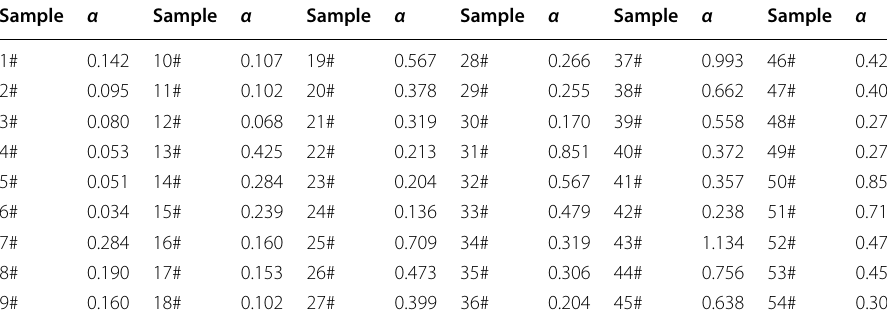
Table 2 Corrosion degree of